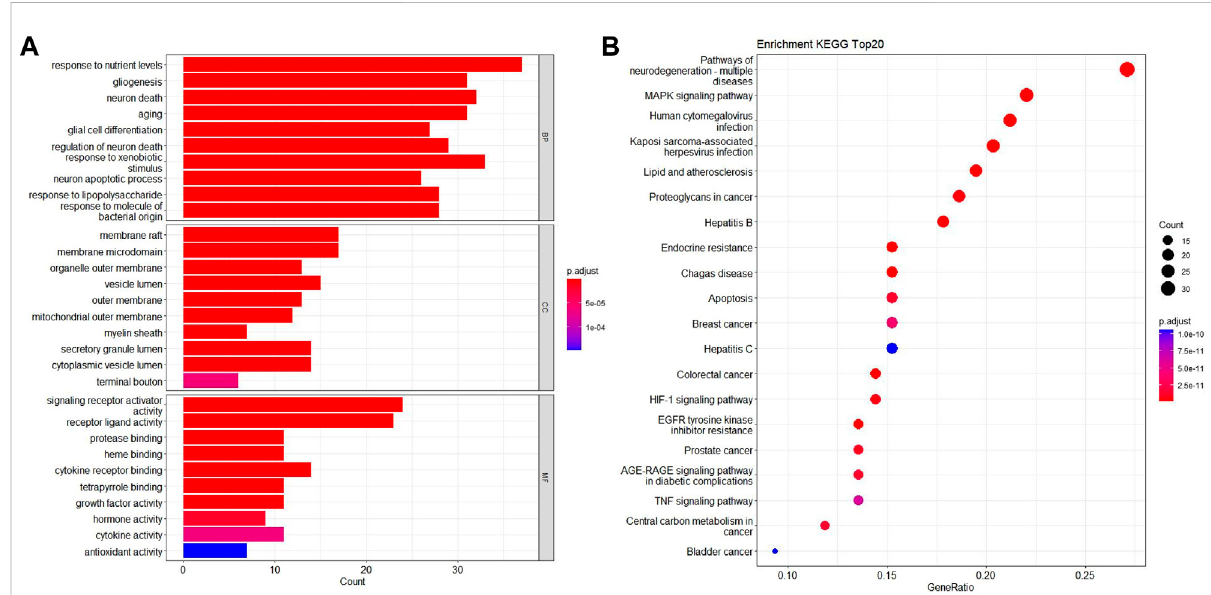
FIGURE 4 GO biological process and KEGG pathway enrichment analysis. (A) The bubble diagram of GO enrichment analysis of 133 intersection targets, including the top 10 signi fi cant enrichment terms of BP, CC and MF. (B) The bar plot diagram of KEGG pathway enrichment analysis of 133 intersection targets (top 20).